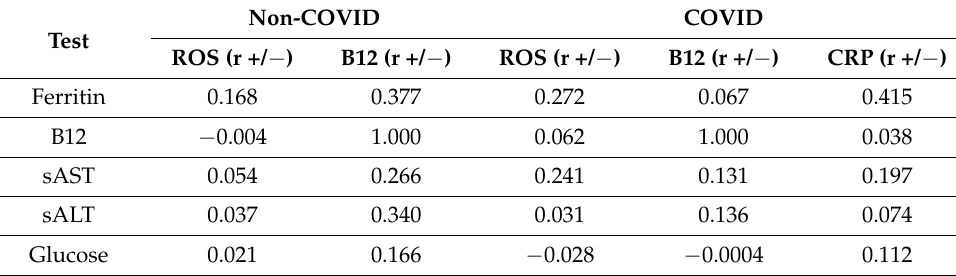
Table 5. Correlation of B12, ROS and CRP values with the analyzed biochemical